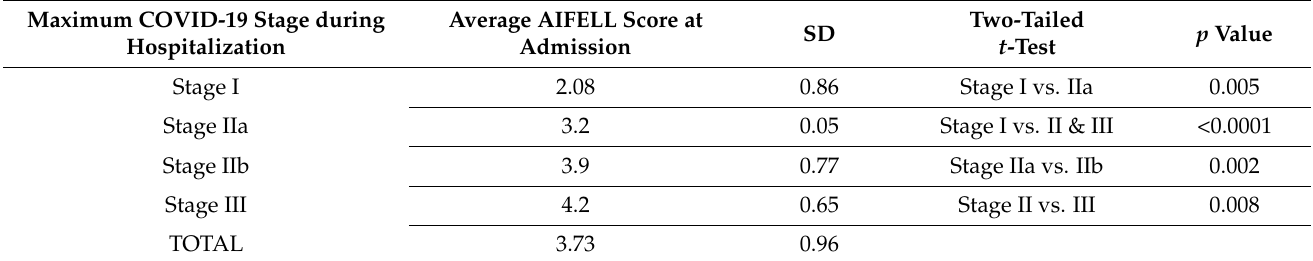
Table 2. Distribution of the AIFELL scores according to COVID-19